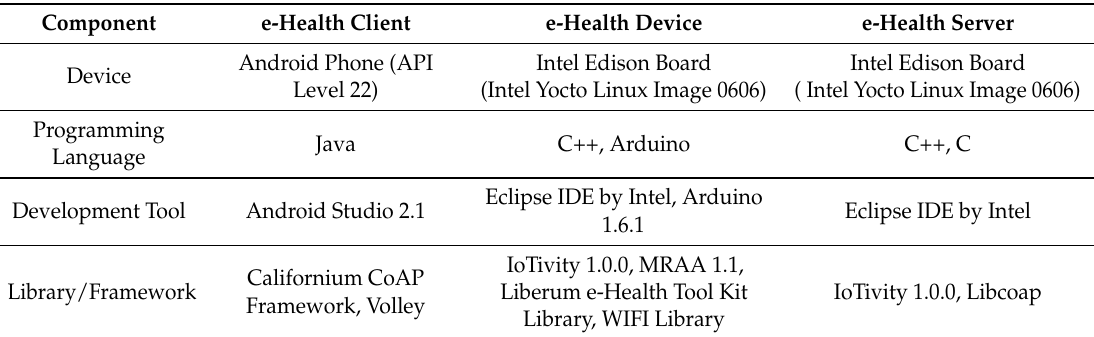
Table 3. Development